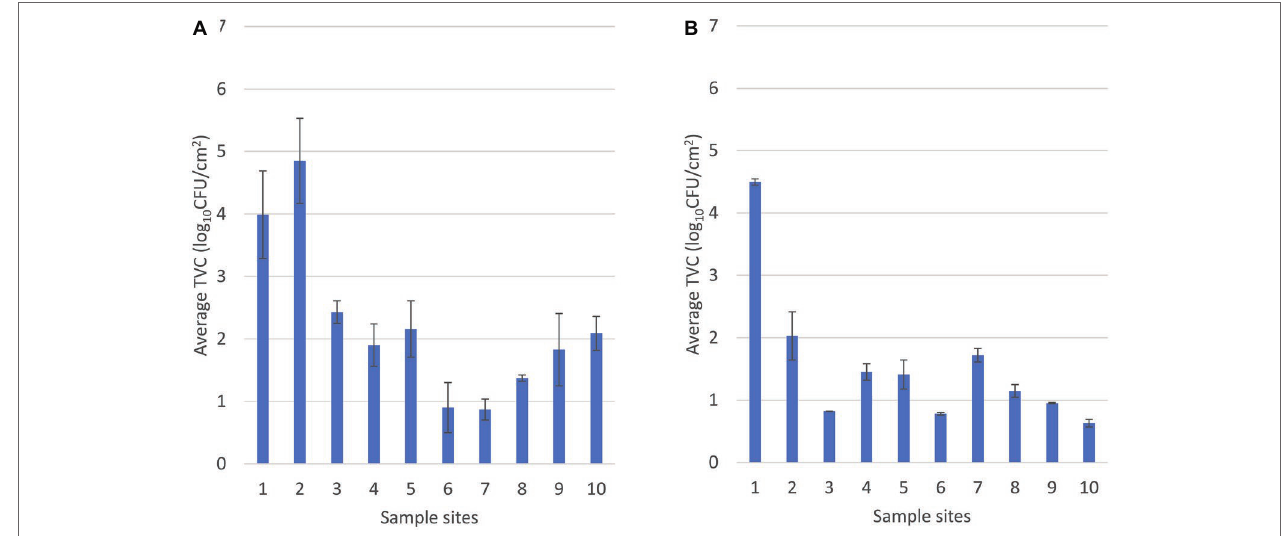
FIGURE 2 | Mean total viable count of environmental samples sequentially arranged throughout the slaughter floor in abattoir A (A) and abattoir B (B) . In (A) , 1 and 2, pre-hide pull; 3, post-hide pull; 4, post-evisceration; 5, pre-scales; 6 and 7, post-scales; 8, pre-trim; 9, trimming; 10, chiller. In (B) , 1, pre-hide; 2 and 3, post-hide; 4, pre-evisceration; 5, post-evisceration; 6, pre-scales; 7, post-scales; 8 and 9, post-trim; 10, chiller entry.